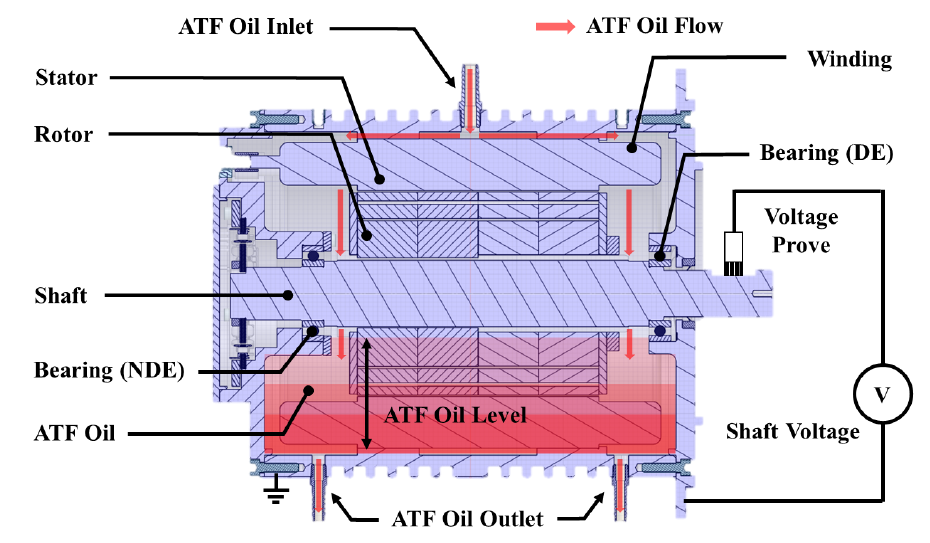
Figure 1. Schematic of a traction motor with direct-oil-cooling